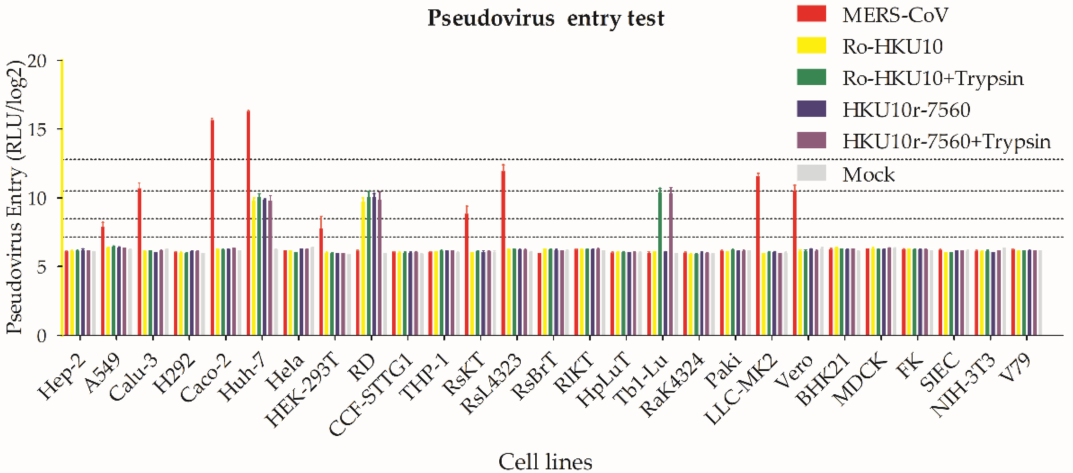
Figure 7. HKU10 spike-mediated pseudovirus entry. Ro-BtCoV HKU10, LA7560, and MERS-CoV spike-mediated pseu- dovirus were produced to screen their cell tropism. For Trypsin treatment, pseudoviruses were incubated with 50 µ g/mL TPCK-treated trypsin at room temperature for 10 min, and then add 50 µ g/mL soybean trypsin inhibitor to stop the reactions. Trypsin treated or untreated pseudoviruses were added to cells and incubated. Then, 48 h post infection, cells were lysed and luciferase were